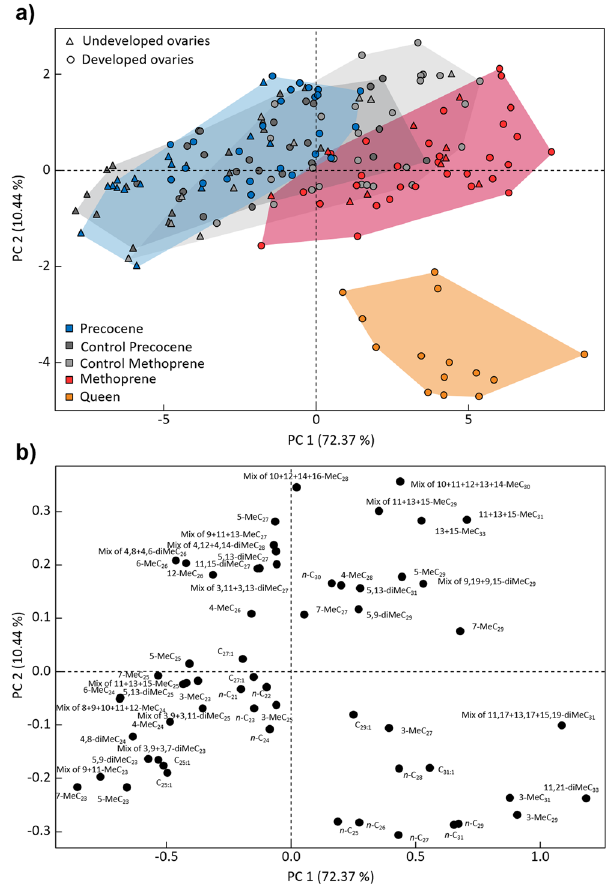
Figure 2. Principal component analysis of JH-induced changes in cuticular hydrocarbon profiles. ( a ) PC factor scores (calculated from a PCA on Aitchison transformed relative compound abundances) show that treatment with the JH-analog methoprene (red) induced worker profiles to become more queen-like (orange), whereas treatment with the JH inhibitor precocene-I had a slight reverse effect ( n = 40 per group for workers and n = 14 for egg-laying queens). Workers with developed ovaries (circles) can also be observed to be more queen-like along PC axis 1 than workers with undeveloped ovaries (triangles). ( b ) Corresponding factor loadings for the different hydrocarbon compounds. The four known queen pheromones appear in the lower right quadrant ( n -C 27 , n -C 28 , n -C 29 and 3-MeC 29